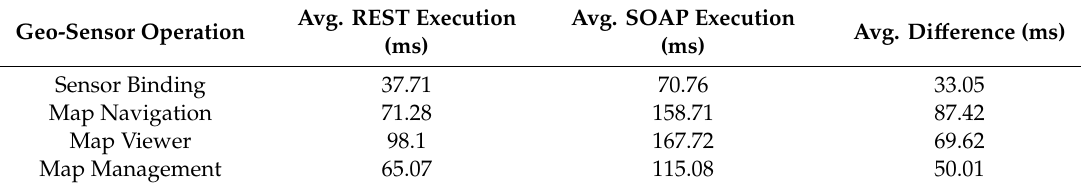
Table 4. Average performance results comparisons between REST and